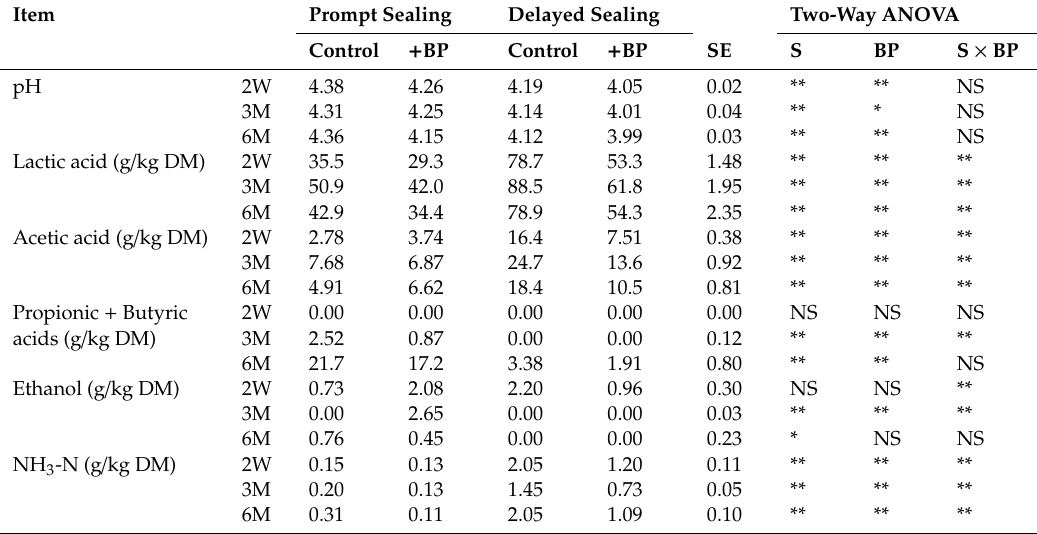
Table 3. Composition of fermentation products of factory 2 soybean curd residue silage prepared with prompt and delayed sealing (S) and with and without beet pulp (BP) addition. Item Prompt Sealing